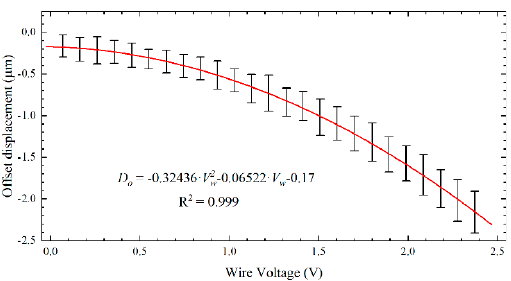
Figure 20. Arm displacement as a function of wire voltage.